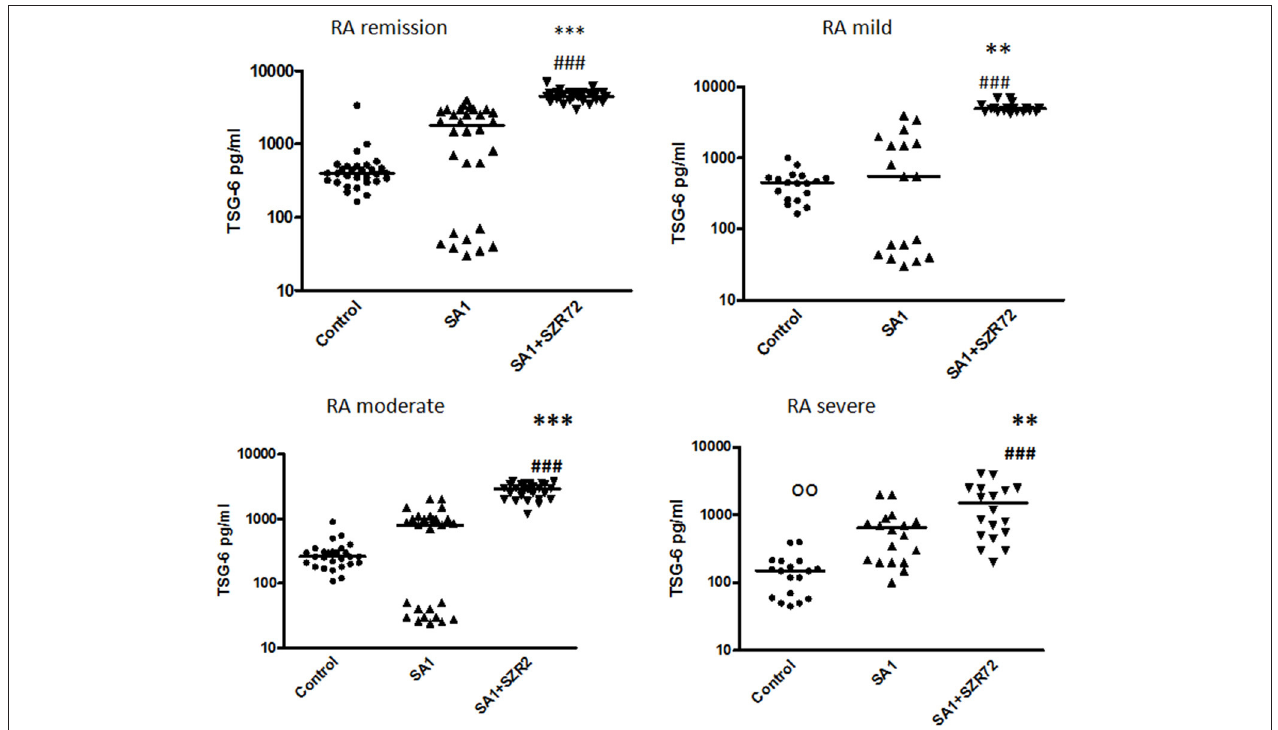
FIGURE 5 | The effect of SZR72 on TSG-6 production in human whole blood cells of various groups of patients with RA stimulated by heat-inactivated Staphylococcus aureus. Each dot represents the individual value for one subject, and the horizontal lines denote the medians. Significance was determined by the Friedman’s test and Dunn’s post-test. Remission group: n = 30, p < 0.0001; control vs. SA1, non-significant; control vs. SA1 + SZR72, ### p < 0.001; SA1 vs. SA1 + SZR72, *** p < 0.001 according to the Dunn’s post-test. Mild group: n = 18: p < 0.0001; control vs. SA1, non-significant; control vs. SA1 + SZR72, ### p < 0.001; SA1 vs. SA1 + SZR72, ** p < 0.01. Moderate group: n = 27, control vs. SA1, non-significant; control vs. SA1 + SZR72, ### p < 0.001; SA1 vs. SA1 + SZR72, *** p < 0.001. Severe group: n = 18: control vs. SA1, oo p < 0.01; control vs. SA1 + SZR72, ### p < 0.001; SA1 vs. SA1 + SZR72, ** p <